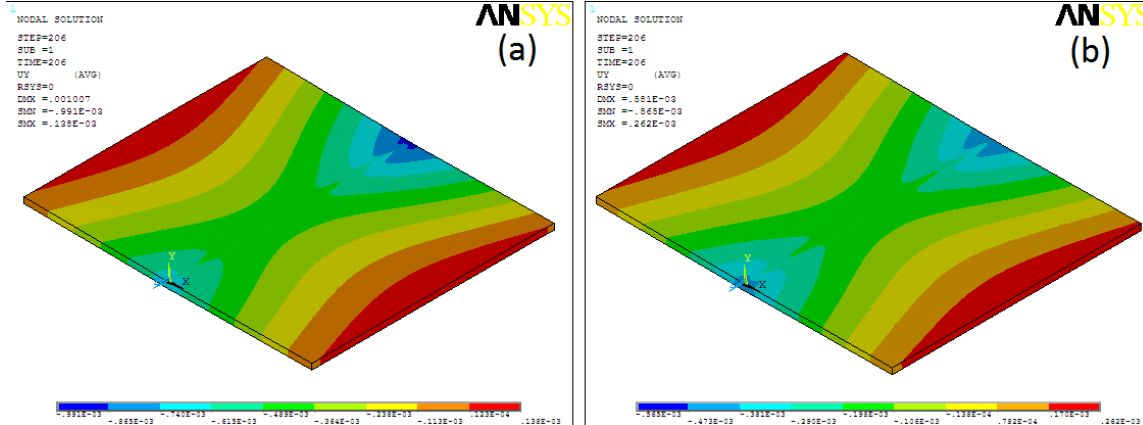
Figure 9: Vertical deflection distribution: (a) No Constraint and (b) Fully constraint (Case C).